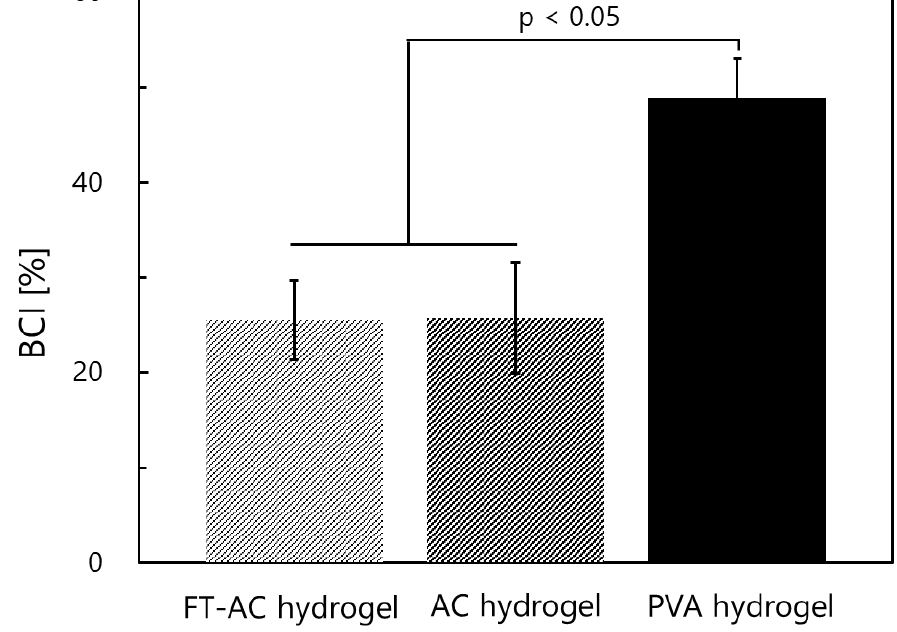
Figure 5. Hemostatic properties of CG26 AC hydrogels, CG26 FT-AC hydrogels, and PVA